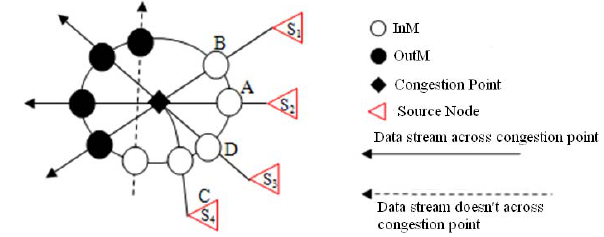
Fig. 5. The violation of a distrustful source node in a domain.